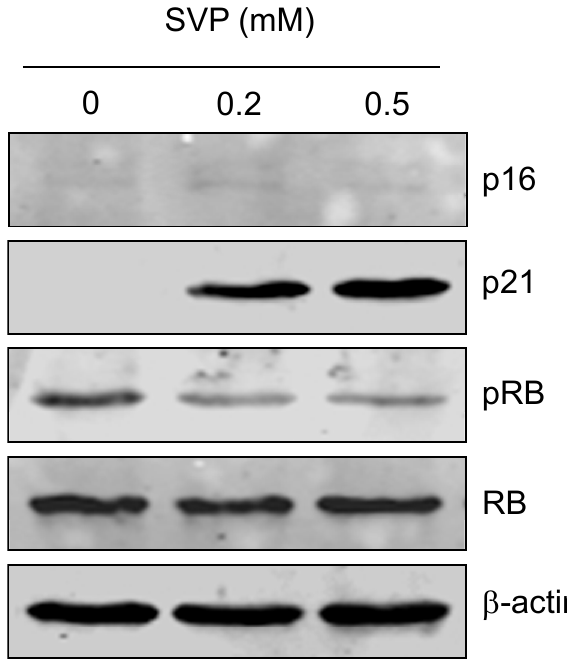
Figure 4. Effects of SVP on expression of cell senescence regulatory genes in Bel-7402. Bel-7402 cells were collected after 0.2 and 0.5 mM of SVP treatment for 120h, and subjected to western blots using antibody against p16, p21, RB and pRB. β -actin was used as a loading